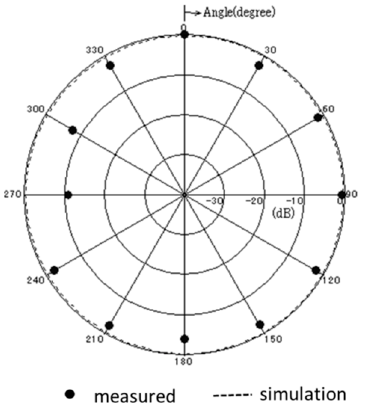
Figure 14. Measured and simulated radiation pattern of the proposed antenna.